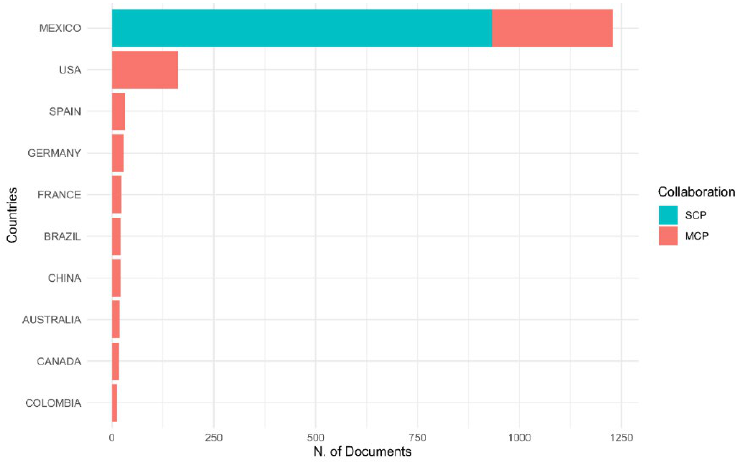
Figure 2. The number of articles associated with the different countries related to Mexican bioinformatics. Only the ten most outstanding countries related to Mexican bioinformatics are plotted. The label SCP refers to single publication country publications, and MCP corresponds to multiple publications countries.